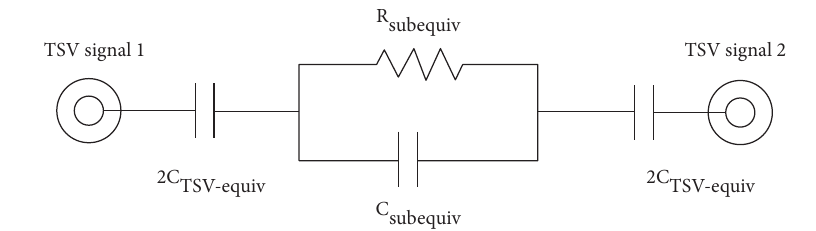
Figure 5: A simplified model of the TSV-TSV noise coupling circuit.